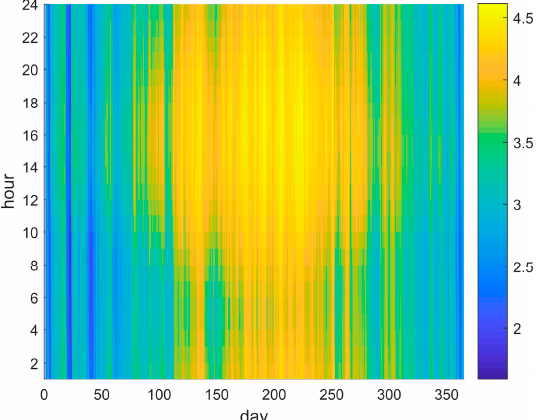
ffi cient of performance (COP) estimation for one Figure 3. Hourly coefficient of performance (COP) estimation for one year. Figure 3. Hourly coe Figure 3. Hourly coefficient of performance (COP) estimation for one year.